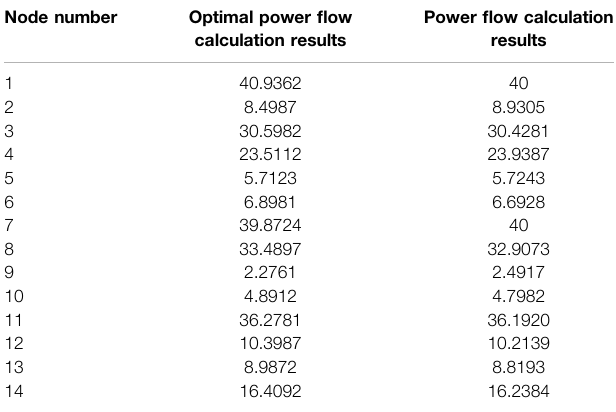
TABLE 5 | Water fl ow of the heat network pipeline (kg/s). Node